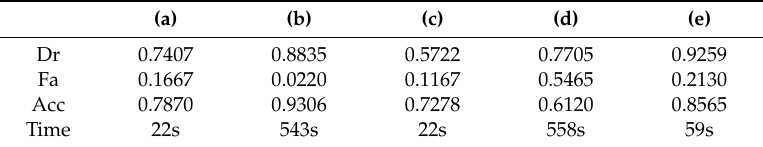
Table 8. Detection results in di ff erent feature